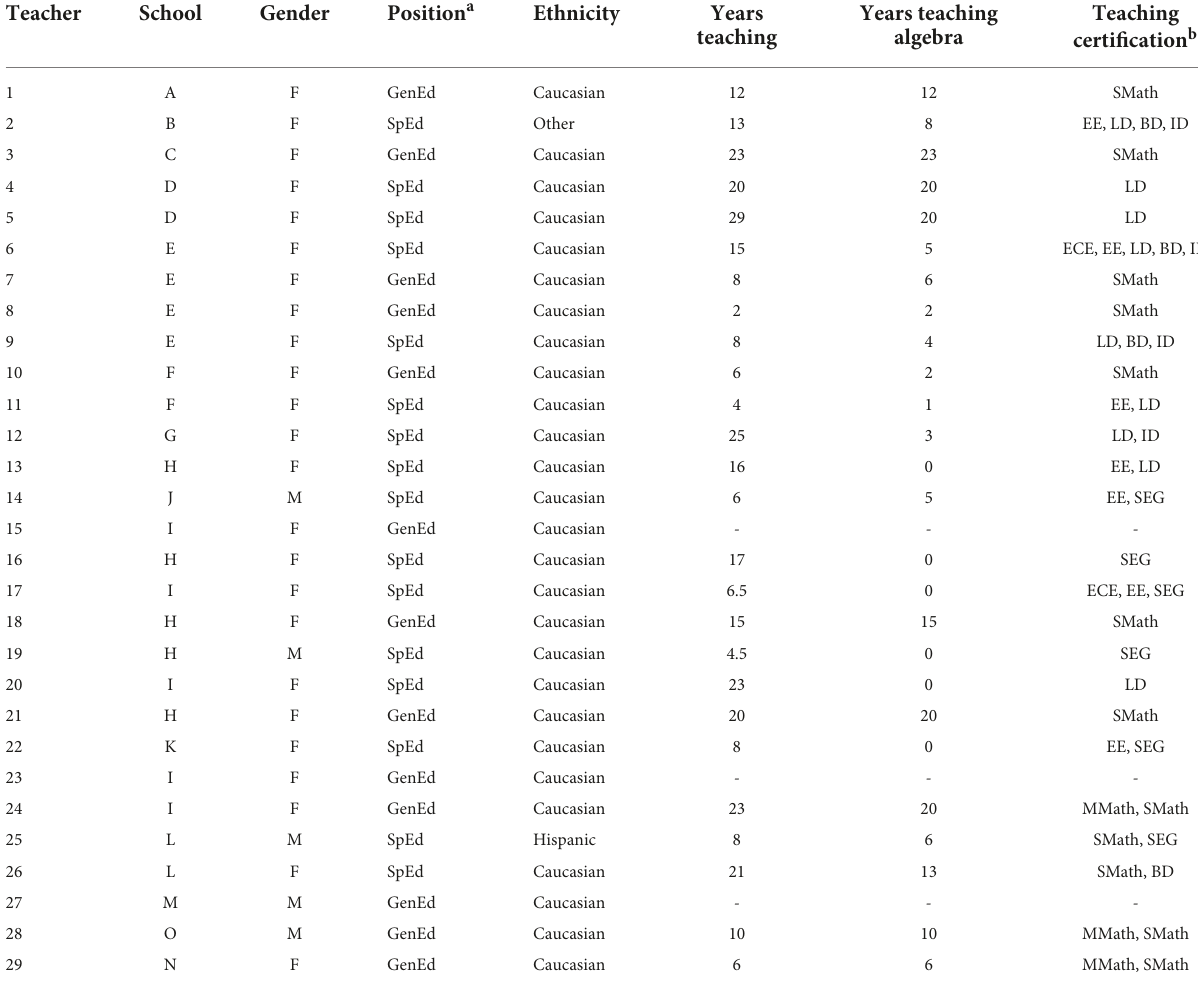
TABLE 1 Demographic information for participating